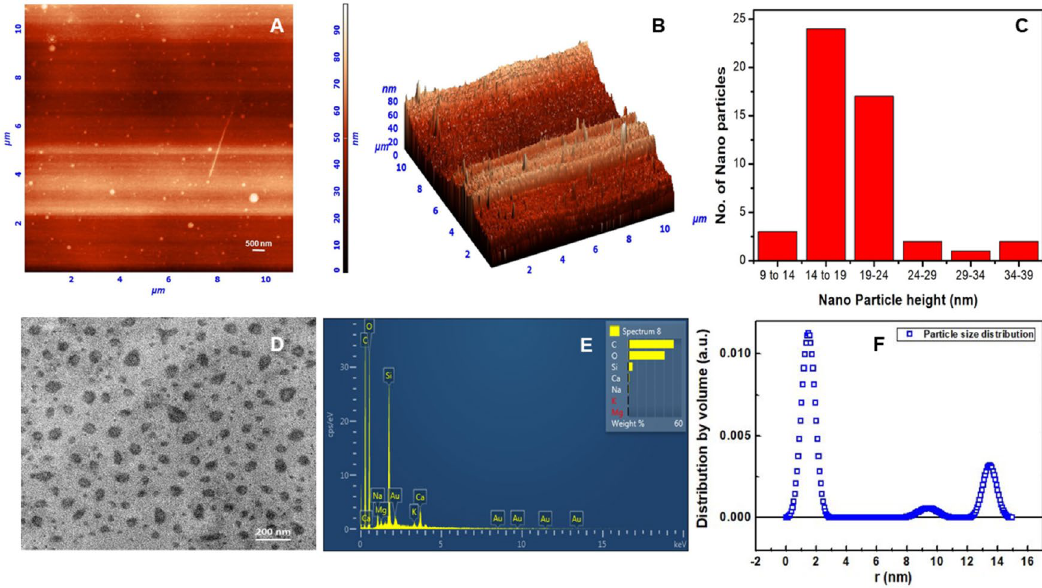
Figure 2. ( A ) AFM of CND ( B ) Three dimensional height projection of CND ( C ) Particle height distribution of CNDs from AFM ( D ) TEM image of CND E) EDX spectrum of CND ( F ) Particle size distribution weighted by volume of CNDs from small angle scattering (SAXS) data obtained by indirect fourier transform (IFT)